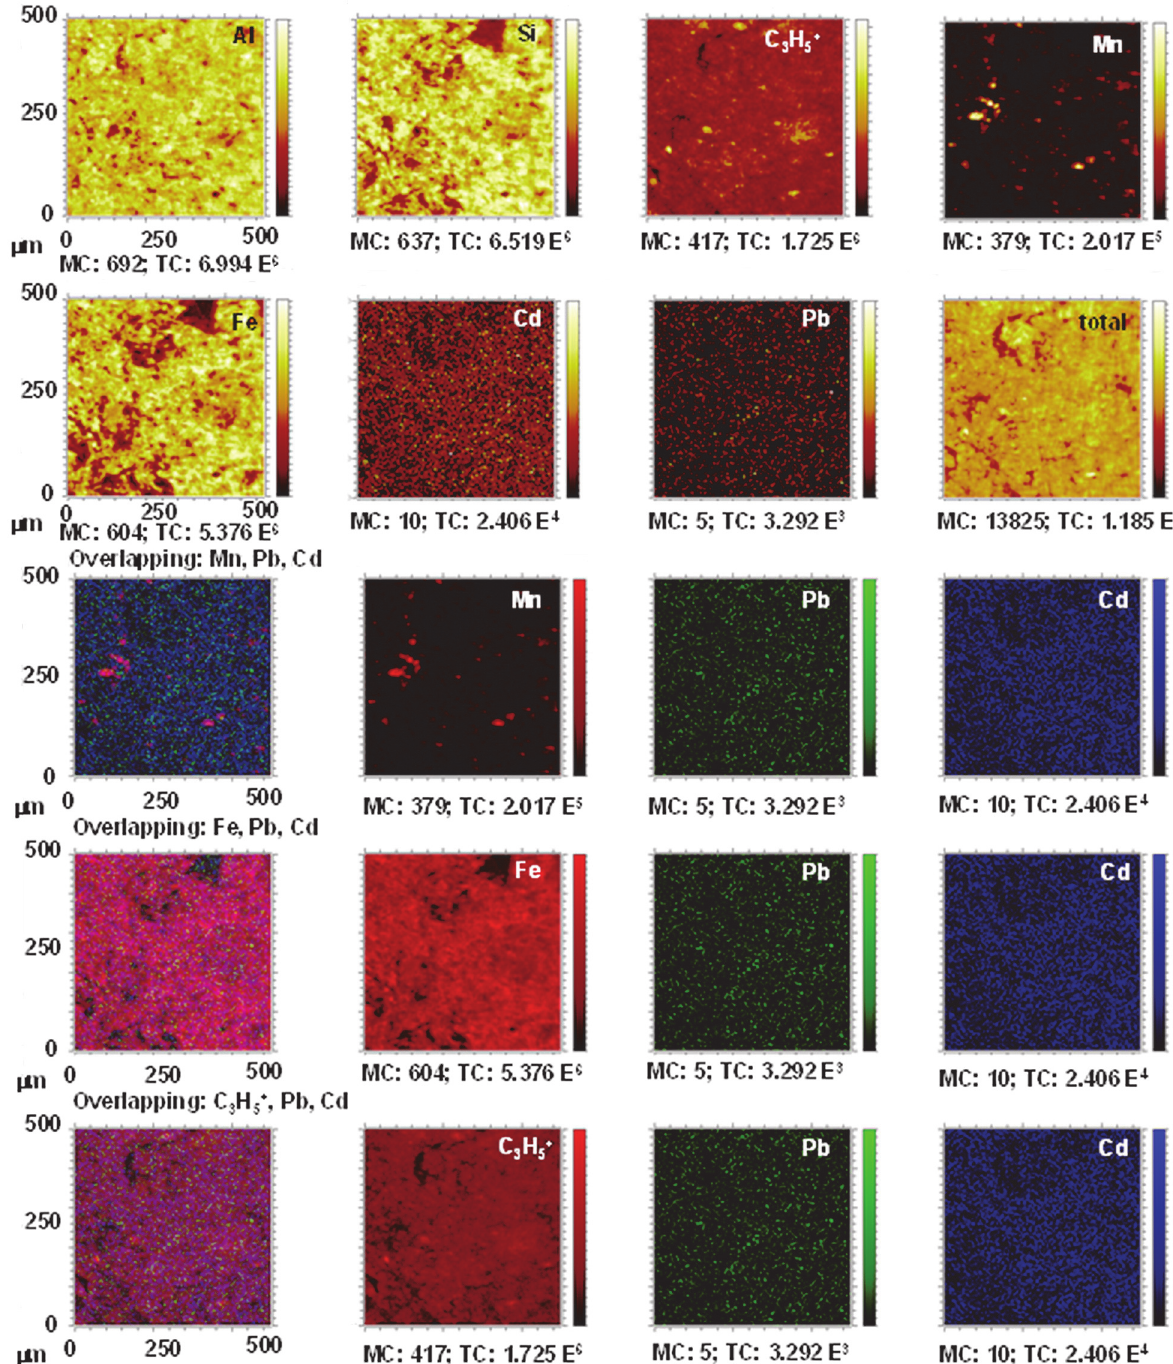
Fig 5. Untreated EL.Bt horizon. TOF-SIMS images of Al, C 3 H 5+ , Si, Fe and Mn ions, and overlapping all the signals with Pb 2+ and Cd 2+ . Images of overlapping: Mn + Pb + Cd; Fe + Pb + Cd; and C 3 H 5+ + Pb + Cd showing the concordance between signals.